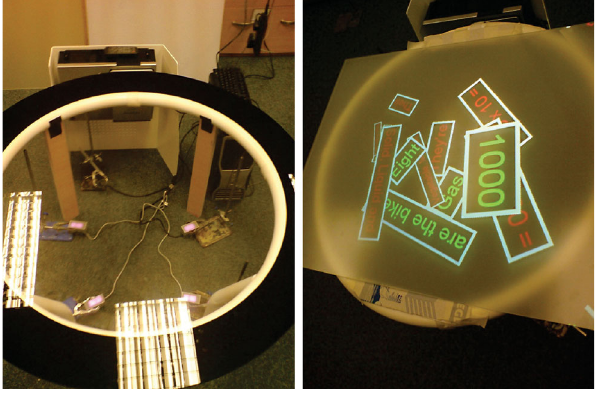
Fig. 10 A prototype of a circular tabletop